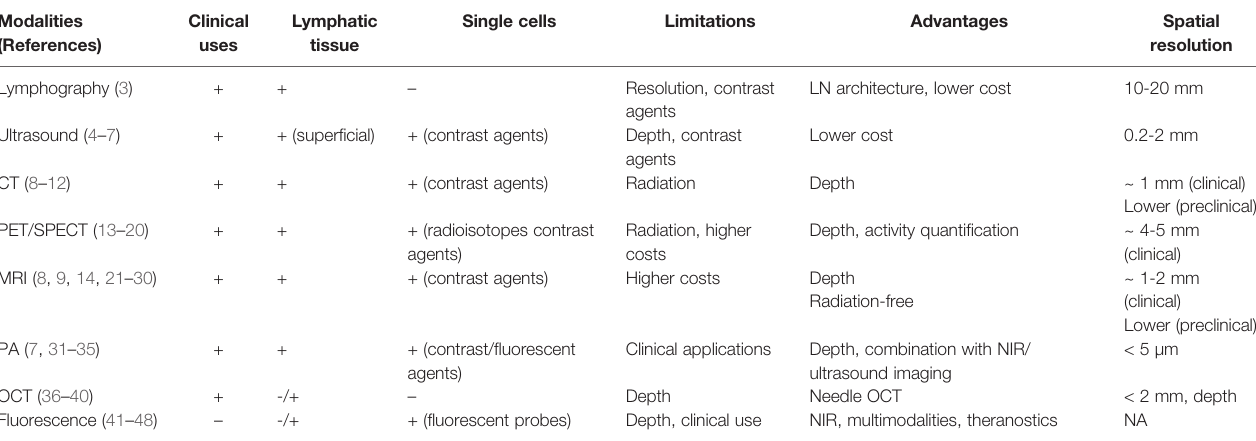
TABLE 1 | Critical assessment of the imaging modalities for intravital immune